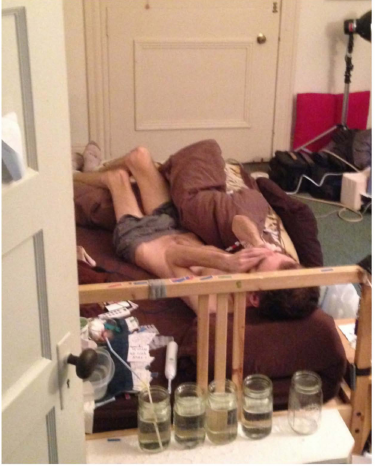
Figure 3. Extreme Distress and Weight Loss.